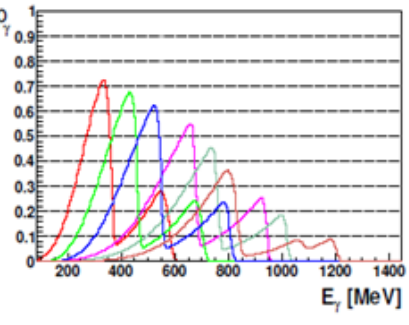
Figure 2. The linear polarisation degree for six di ff erent coherent peak settings, from 350 MeV to 850 MeV [4].